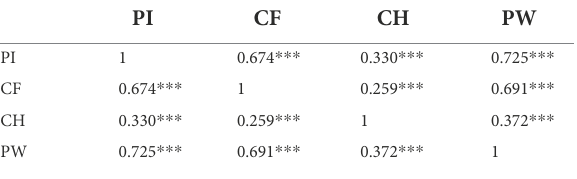
TABLE 1 Correlation matrix of the studied variables.